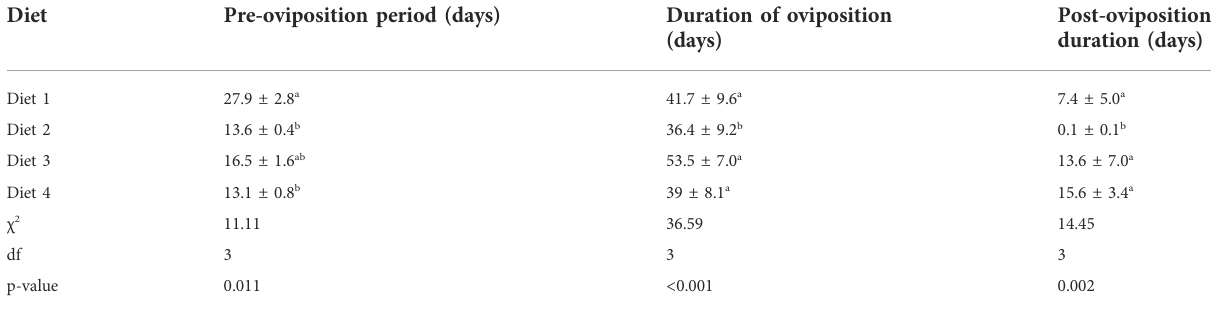
TABLE 5 Mean (±SE) pre-oviposition, oviposition, and post-oviposition duration of Ruspolia differens reared on different diets.